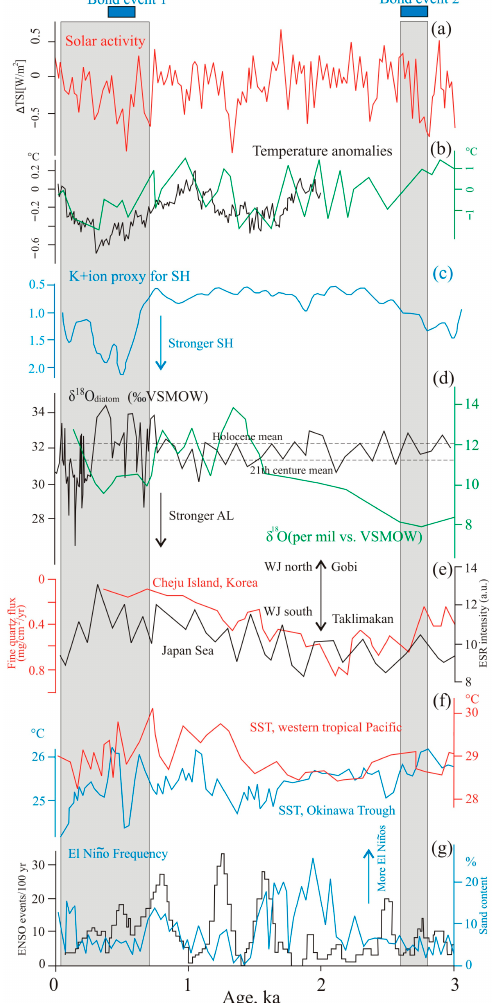
Figure 11. Compilation of selected proxy records of sun activity, palaeotemperatures, SH and AL intensity, WJ shift, SST of western subtropical and tropical Pacific, and El Niño frequency for the past 3000 years. ( a ) Solar activity fluctuations reconstructed based on 10 Be measurements in polar ice [6]. ( b ) Black line indicates relative decadal mean temperature variations ( ◦ C) for 1961–1990 CE with estimations of extra-tropical Northern Hemisphere (90–30 ◦ N) [90]. Green line—the reconstruc- tion of annual temperatures for the Amur River region from modern average temperature [100].